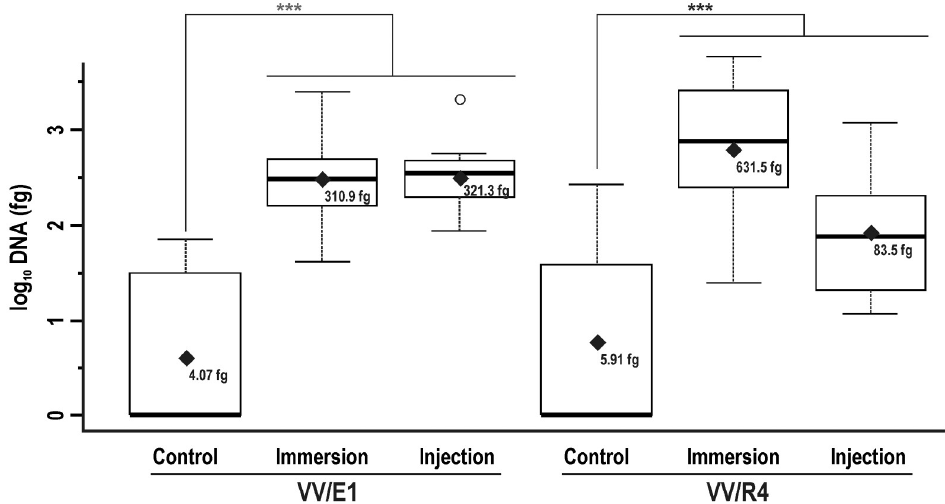
Fig 8. Comparison of the effectiveness of inoculation by immersion vs. injection at RI. Box plot showing DNA amounts at RI of Streptomyces sp. VV/E1 and Streptomyces sp. VV/R4 strains in plants inoculated by immersion or injection as compared to control (untreated) plants. Black rhombuses correspond to average values (back transformed) for each treatment. Asterisks indicate significant differences according to the LSD test: � p < 0.05; �� p < 0.01; ��� p < 0.001. Circles correspond to data outliers (outside the Q1-Q3 range).